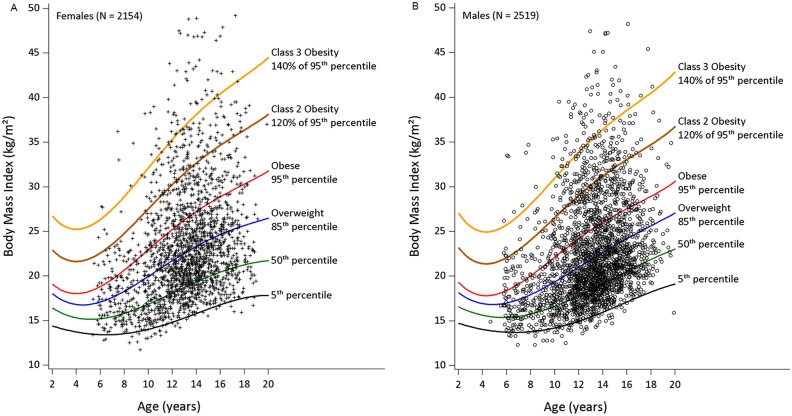
Body Mass Index and BMI-for-age Percentiles of Urban Female and Male Students.Body mass index (BMI) for female students (A) and male students (B) depicted on BMI-for-age percentile growth charts [14]. Each symbol represents one student’s BMI (N = 4673). Severe obesity was defined as class 2 obesity (≥ 120% of the 95th percentile of BMI-for-age) or class 3 obesity (≥ 140% of the 95th percentile) [2].